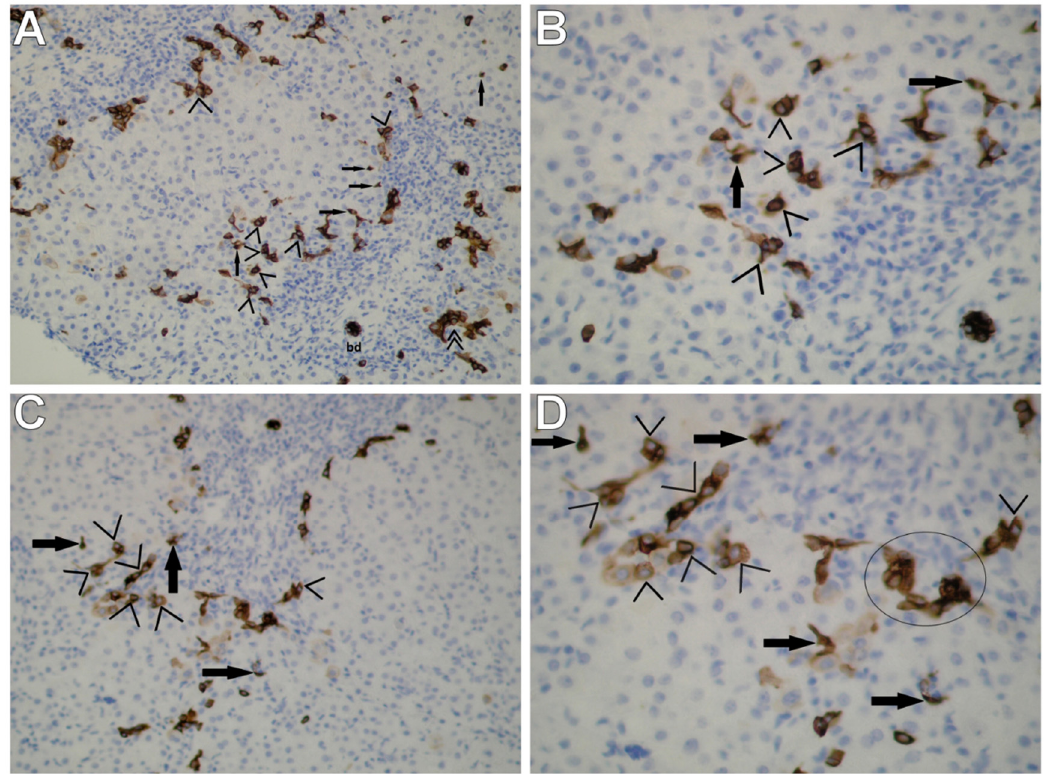
Figure 1. Immunohistochemical staining for CK7 in liver biopsies obtained from children with AIH shows immunoreactive cells of the HPC line in periportal and intralobular regions; density inflammation is observed in portal tracts. ( A ) Periportal and intralobular CK7-positive cells—intermediate hepatocytes (pIMs and iIMs (>)) corresponding to IHCs observed by means of TEM are well-visible, especially in the center of the photograph (on the border between the periportal region and the limiting plate); focally scarce, dispersed, tiny periportal and intralobular progenitor cells (pPCs and iPCs (->)). At the periphery of portal tracts (i.e., at the photograph’s margins), a poor ductular reaction (DR (>>)) at the portal– parenchymal interface was observed—very few neoforming bile ductules as a result of hepatic progenitor cell activation with no or very poorly defined lamina, not surrounded by a continuous basement membrane. A mild DR is accompanied by massive inflammatory infiltration; bd—bile ductule. ( B ) Greater magnification of the central fragment of Figure 1A visualizes numerous CK7-positive cells of the nature of iIMs (>) penetrating the hepatic lobule well; present are also single dispersed CK7-positive cells of the nature of PCs (->)—very small cells with an oval nucleus and a small rim of the cytoplasm (corresponding to UPCs observed by means of TEM). PCs exhibit a strong homogenous cytoplasmic and membranous staining pattern; on the other hand, iMs—intermediate in size—demonstrate a variable cytoplasmic and membranous staining pattern; S1 ( A , B ). Original magnification: ×10, scale bar: 200 µm ( A ); ×40, scale bar: 50 µm ( B ). ( C ) Immunohistochemistry for CK7 demonstrates the picture of numerous periportal intermediate hepatocytes (pIMs (>)) and few periportal and intralobular hepatic progenitor cells (pPCs and iPCs (->)). Portal tract—dilated, with dense inflammation. ( D ) Greater magnification of the central fragment of Figure 1C clearly demonstrates the immunohistochemical pattern of intermediate hepatocytes (>), mainly located in the periportal region; rare immunoreactive progenitor cells present in the vicinity (->). In the “circle,” the microscopic picture may indicate neoformation of a bile ductule, still without its own lumen or basement membrane; S2 ( C , D ). Original magnification: ×20, scale bar: 100 µm ( C ); ×40, scale bar: 50 µm ( D ).